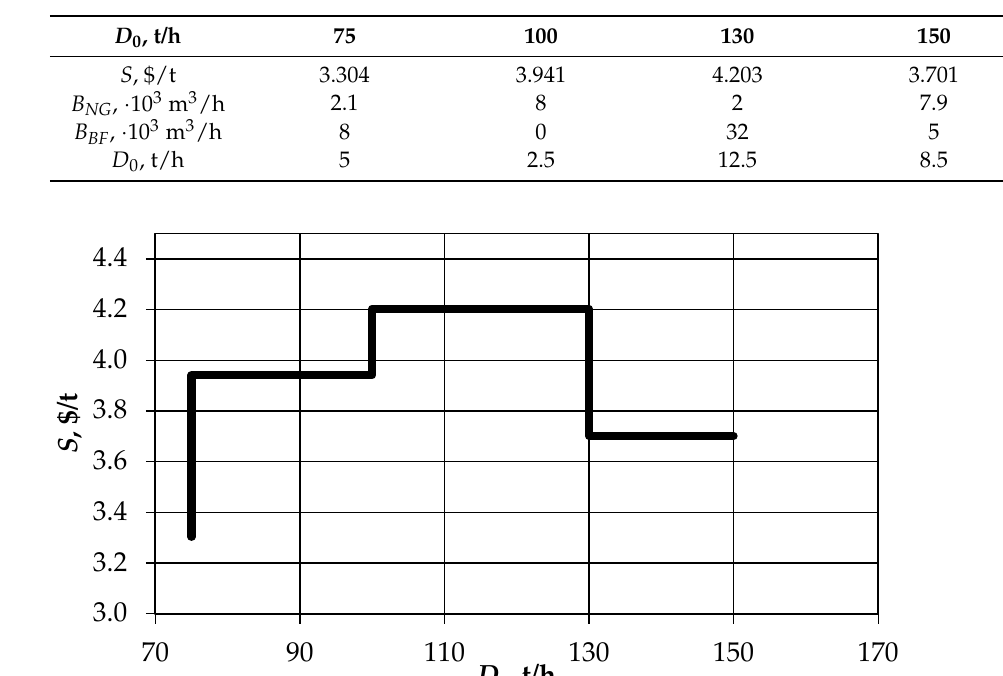
Table 3. Feasibility Model of a TP-7 Boiler Unit.